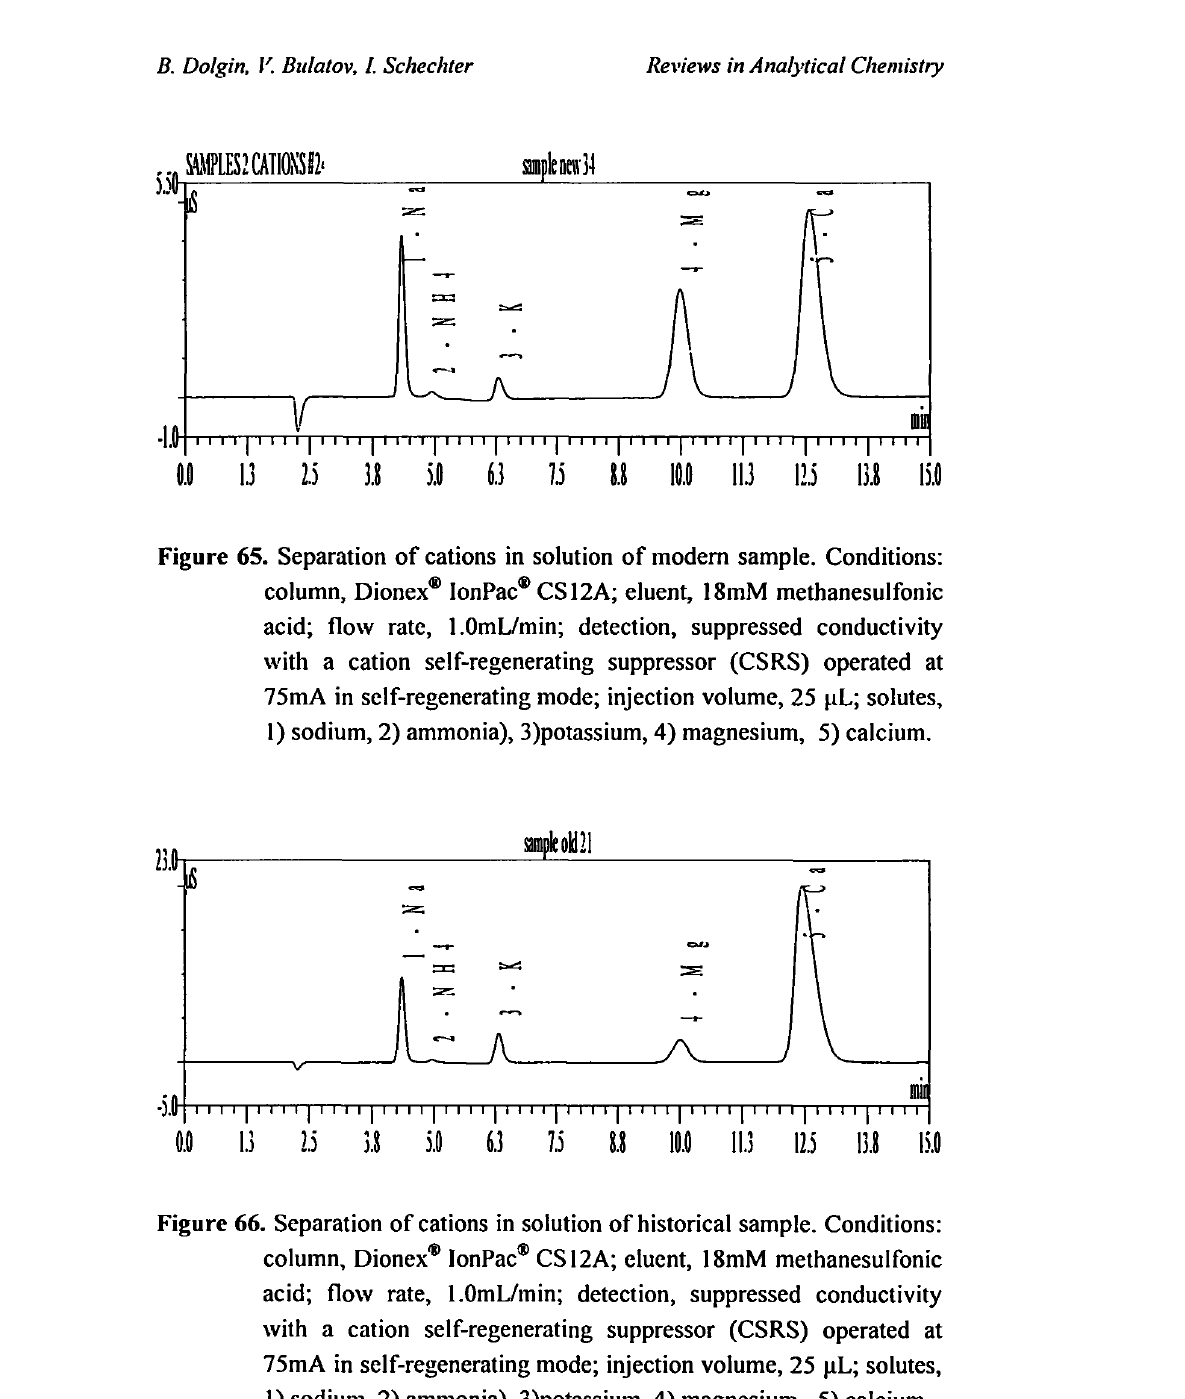
Figure 66. Separation of cations in solution of historical sample. Conditions: column, Dionex® lonPac® CS12A; eluent, 18mM methanesulfonic acid; flow rate, l.OmL/min; detection, suppressed conductivity with a cation self-regenerating suppressor (CSRS) operated at 75mA in self-regenerating mode; injection volume, 25 μι; solutes, 1) sodium, 2) ammonia), 3)potassium, 4) magnesium, 5)